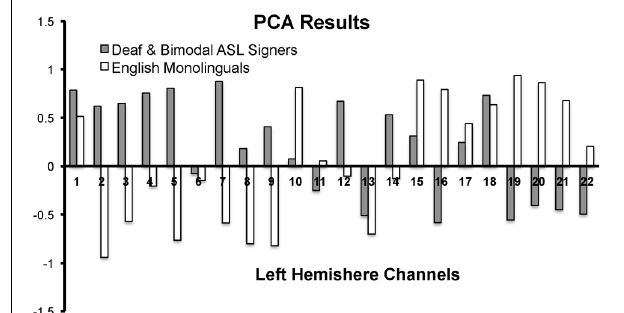
FIGURE 2 | PCA results for the first component for the left hemisphere channels during the Real Sign condition. The first component accounted for 41% variance in English monolinguals and 30% variance in Deaf and Bimodal ASL signers.